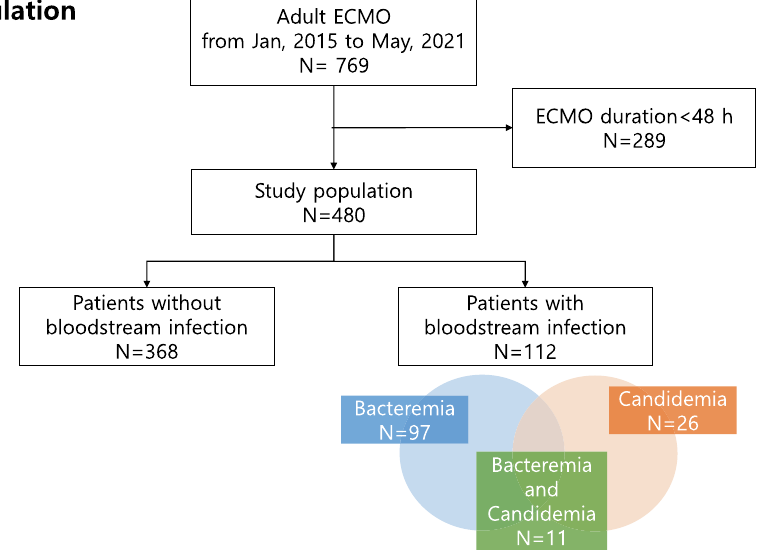
Figure 1. Study flow chart. ECMO Extracorporeal membrane